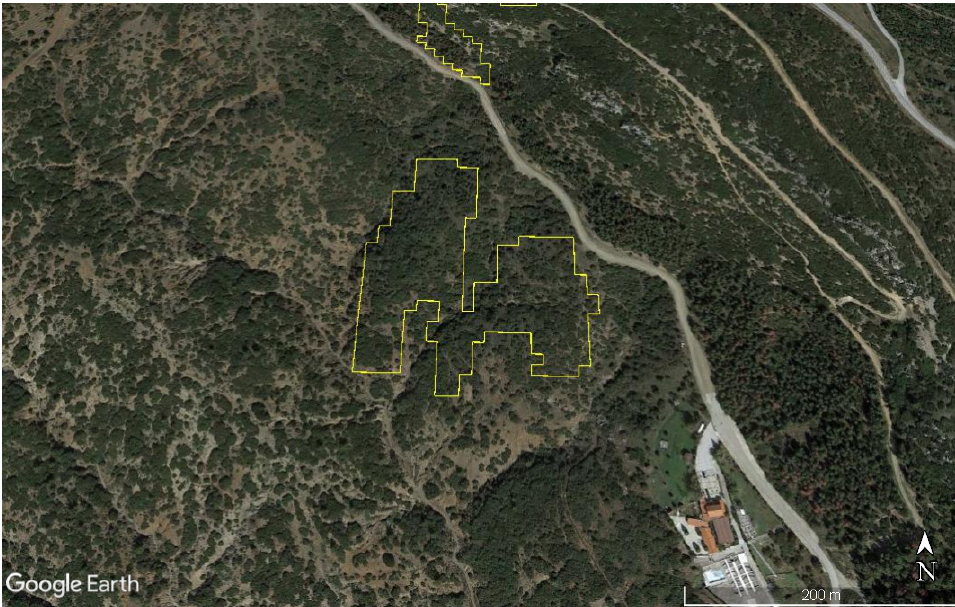
Figure 4. Close view of a testing sample in Google Earth, representing a completely pure dense shrub object (delineated by a yellow polygon).